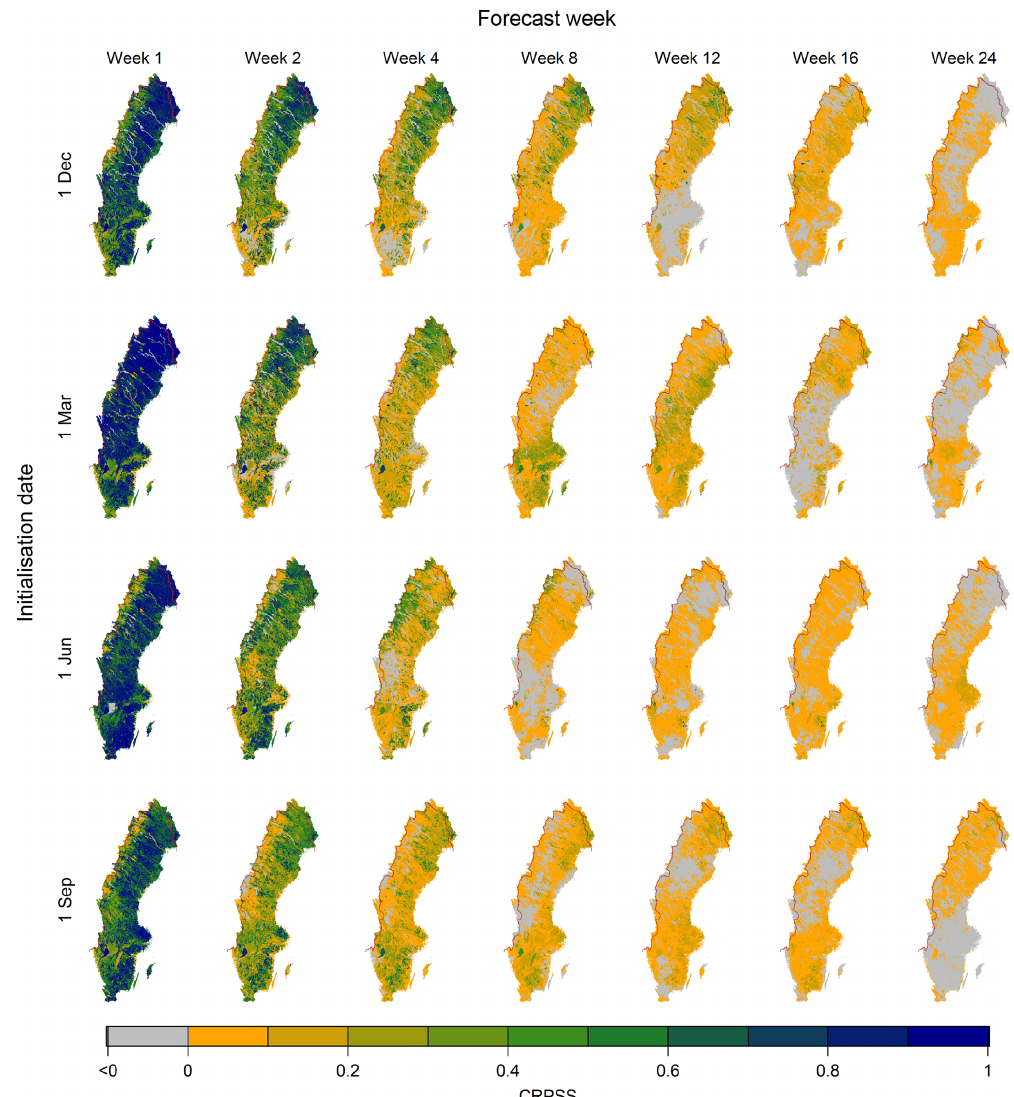
Figure 4. Spatial distribution of streamflow forecast skill (in terms of CRPSS) for selected initialization dates (rows) and forecast time horizons